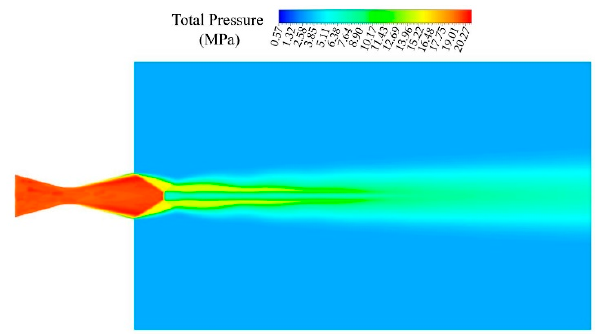
Figure 14. The total pressure at 1.2 s.